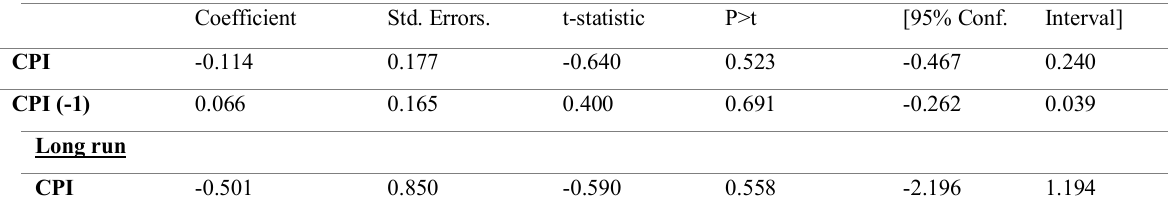
Table 8: Relationship between CPI and Capital